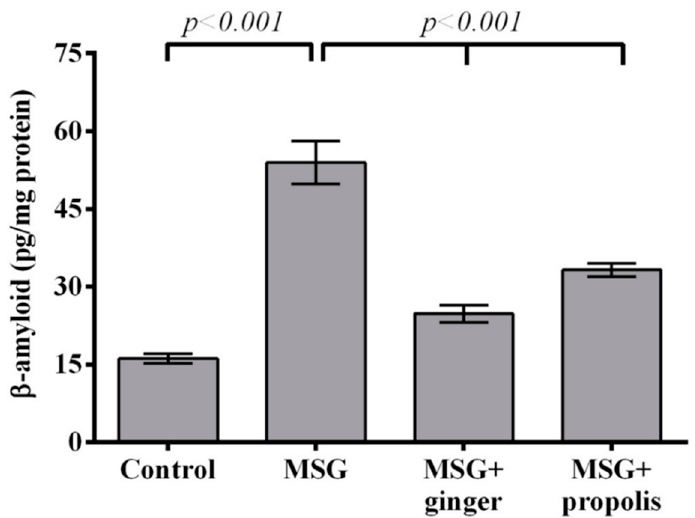
Figure 11. Cerebral cortex free β -amyloid peptides at two months post-treatment. Data are expressed as mean ± SEM ( n = 6). Comparisons were made between normal control and MSG control groups, and also between MSG control and MSG plus ginger or propolis supplement groups.